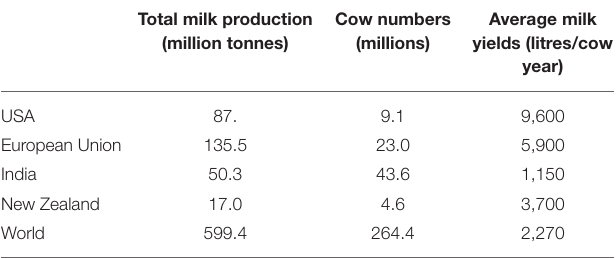
TABLE 1 | Total milk production (million tonnes), cow numbers (millions), and average milk yields of cows (litres per cow per year). Total milk production (million